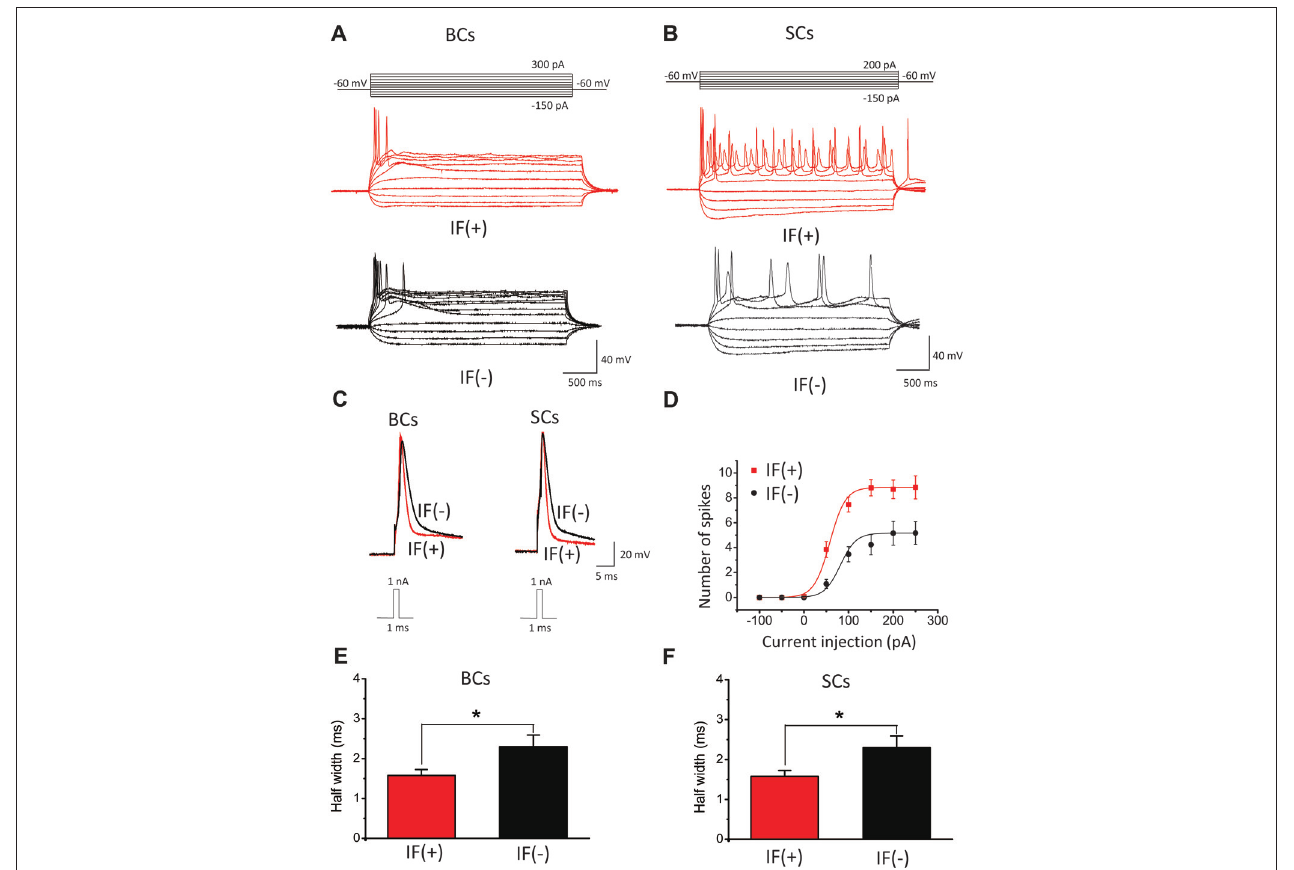
FIGURE 7 | Neurons with IFs exhibit higher level of membrane excitability in P4–7 CN neurons. (A,B) Example traces of action potentials (APs) evoked by depolarizing currents recorded from IF(+) and IF( − ) bushy cells (BCs) and stellate cells (SCs). (C) Half-width of action potentials evoked by 1 nA current injection in 1 ms were compared in IF(+) and IF( − ) neurons, showing much narrower waveform of APs in IF(+) neurons (BCs: IF(+): 1.29 ± 0.14 ms, n = 7; IF( − ): 2.07 ± 0.15 ms, n = 9, p < 0.05; SCs: IF(+): 1.58 ± 0.14 ms, n = 27; IF( − ): 2.3 ± 0.29 ms, n = 14, p < 0.05). The input resistances for IF(+) and IF( − ) cells (measured at − 60 mV with a 5 mV hyperpolarization) are comparable for both types of neurons (SCs: IF(+), 153.5 ± 21.24 M (cid:127) , n = 9 vs. IF( − ), 148.95 ± 21.69 M (cid:127) , n = 12, P > 0.05; BCs: IF(+) 191.35 ± 10.46 M (cid:127) , n = 6; IF( − ) 193.75 ± 25.42 M (cid:127) , n = 8); (D) The number of spikes generated by various depolarization steps in IF(+) and IF( − ) stellate cells. Data were fit with the Boltzmann function. (E,F) Summary plot of the half-width of APs in bushy and stellate cells, showing neurons with IFs have briefer APs.